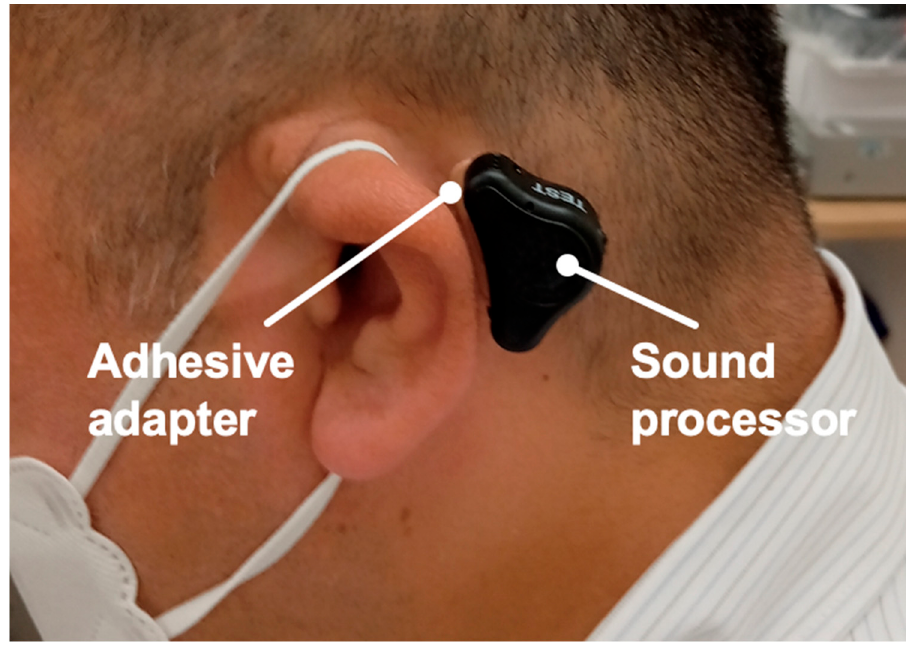
Figure 2. Example of an ear with an ADHEAR. Profile views (left side) of a patient fitted with an ADHEAR. Sound processor is attached to the skin with an adhesive